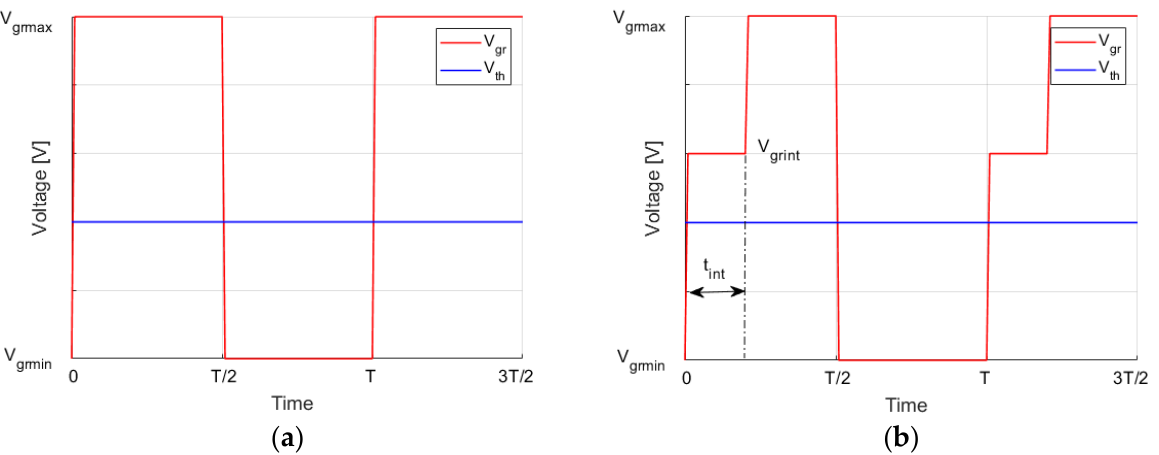
Figure 2. Typical gate driver signals: ( a ) standard two stage gate-drive control signal, ( b ) di/dt turn-on control using AGVC.